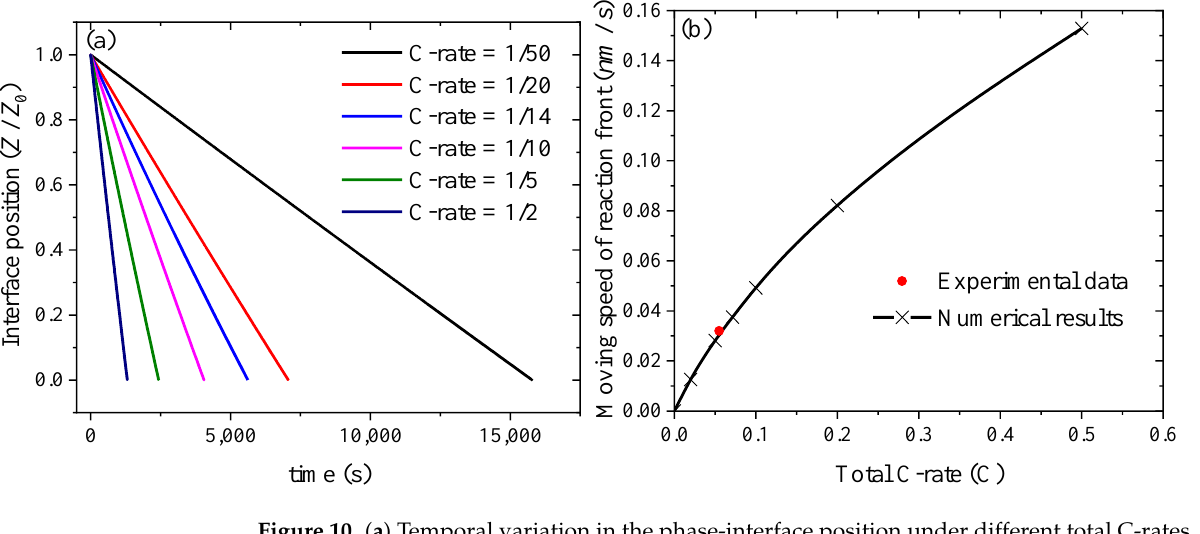
Figure 10. ( a ) Temporal variation in the phase-interface position under different total C-rates, and ( b ) variation of the moving speed of the reaction front with total C-rate, and a Si film thickness of 230 nm.